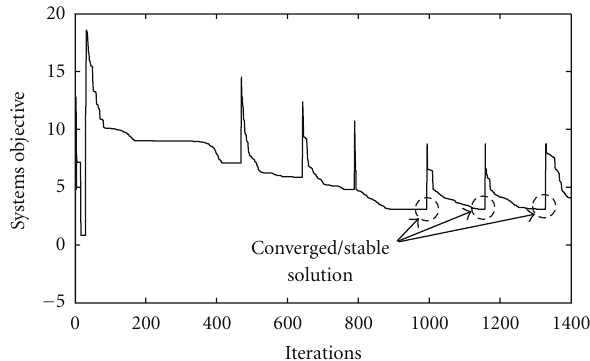
Figure 7: Solution convergence plot for Case